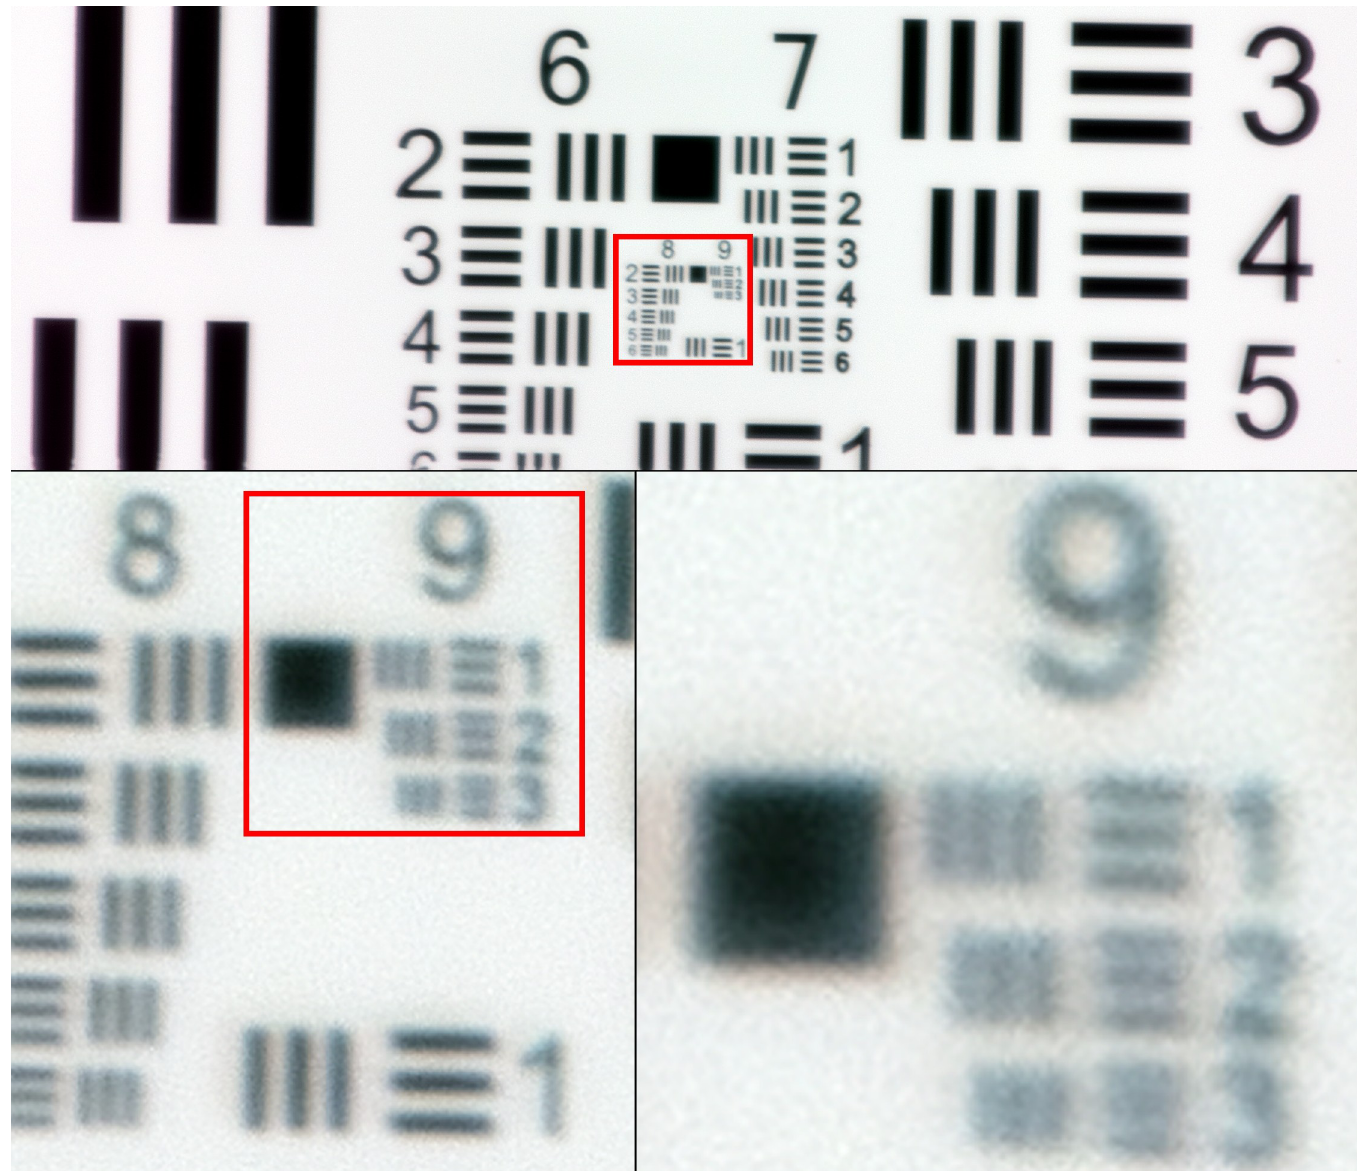
Fig 2. US Air Force 1951 three-bar resolution test chart. Images captured with miniature microscope scanner. Enlarged images showing smallest resolvable bars (group 9, element 2–3), corresponding to a spatial resolution of approximately 0.9 μ m.